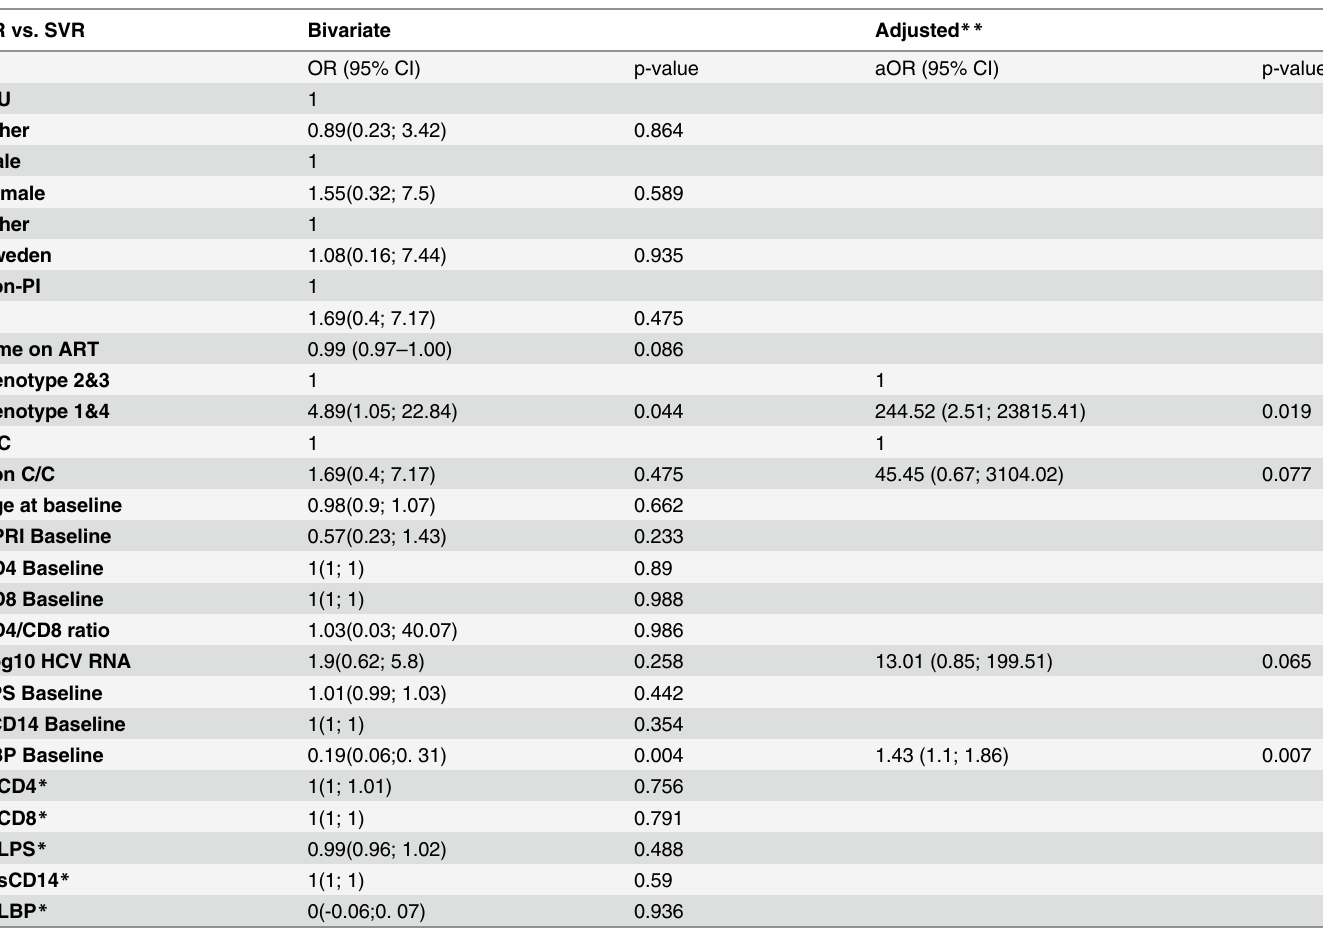
Table 2. Bivariate and multivariable Logistic regression for Non-response to HCV treatment.